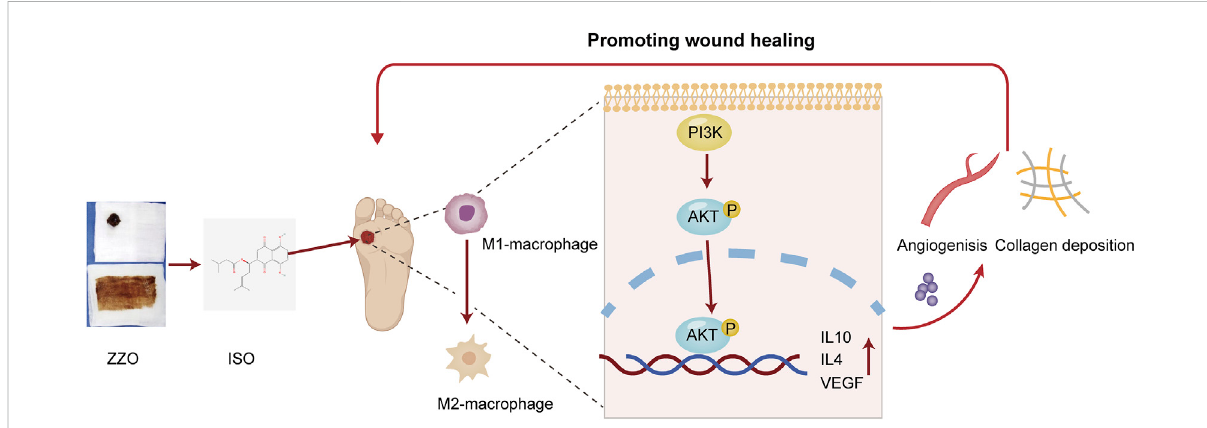
FIGURE 10 Mechanisms of ZZO anti-DU. ZZO could promote M2 polarization by activating the PI3K/AKT pathway and then secreting IL-4, IL10, and VEGF to promote collagen deposition and angiogenesis. These processes help wound healing faster in DU